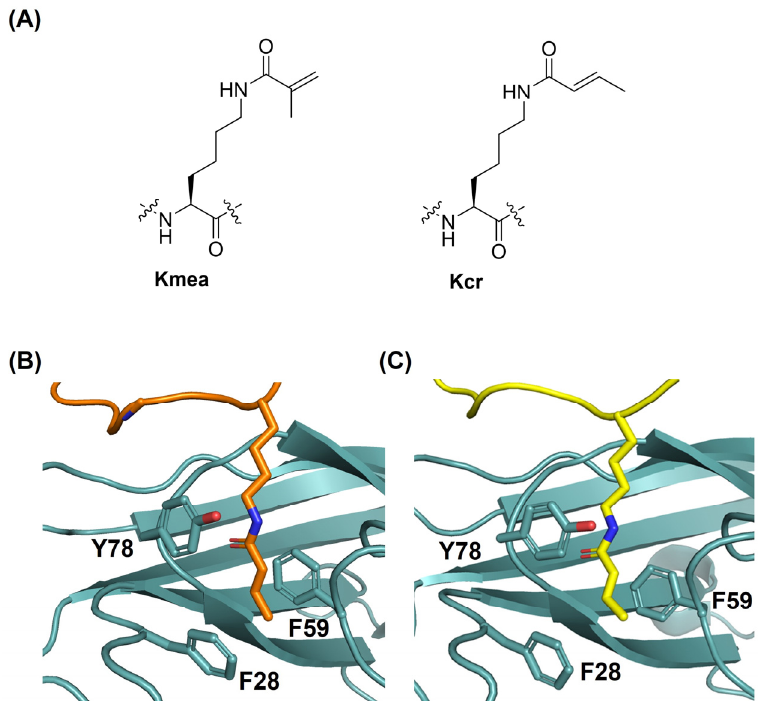
Figure 1. Recognition of methacryllysine and crotonyllysine by the AF9 YEATS domain. ( A ) Struc- tures of methacryllsyine (Kmea) and crotonyllysine (Kcr). ( B ) A view of the crystal structure of AF9 YEATS (cyan) complexed with histone H3K18cr (orange) (PDB ID: 2NDG). ( C ) A view of the crystal structure of AF9 YEATS (cyan) complexed with histone H3K9cr (yellow) (PDB ID: 5HJB).